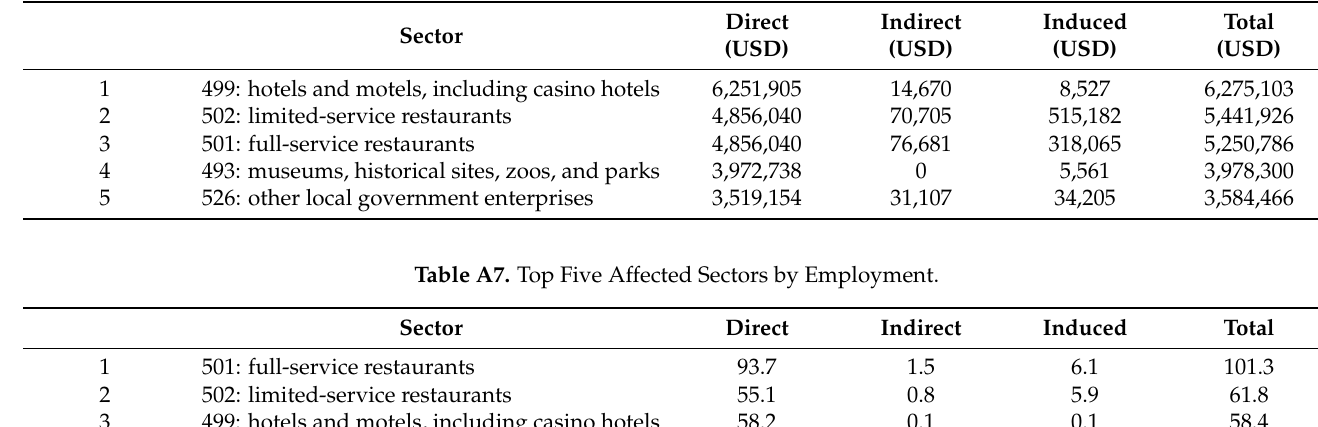
Table A6. Top Five Affected Sectors by Revenue.